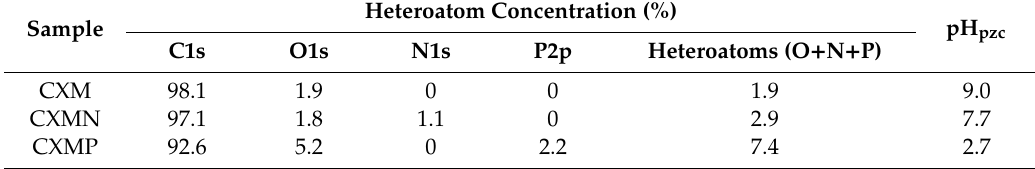
Table 1. Zeta potential at zero charges (pH pzc ) and atomic concentration on the surface of carbon xerogel microspheres (CXMs) and CXMs functionalized with melamine (CXMN) and phosphoric acid